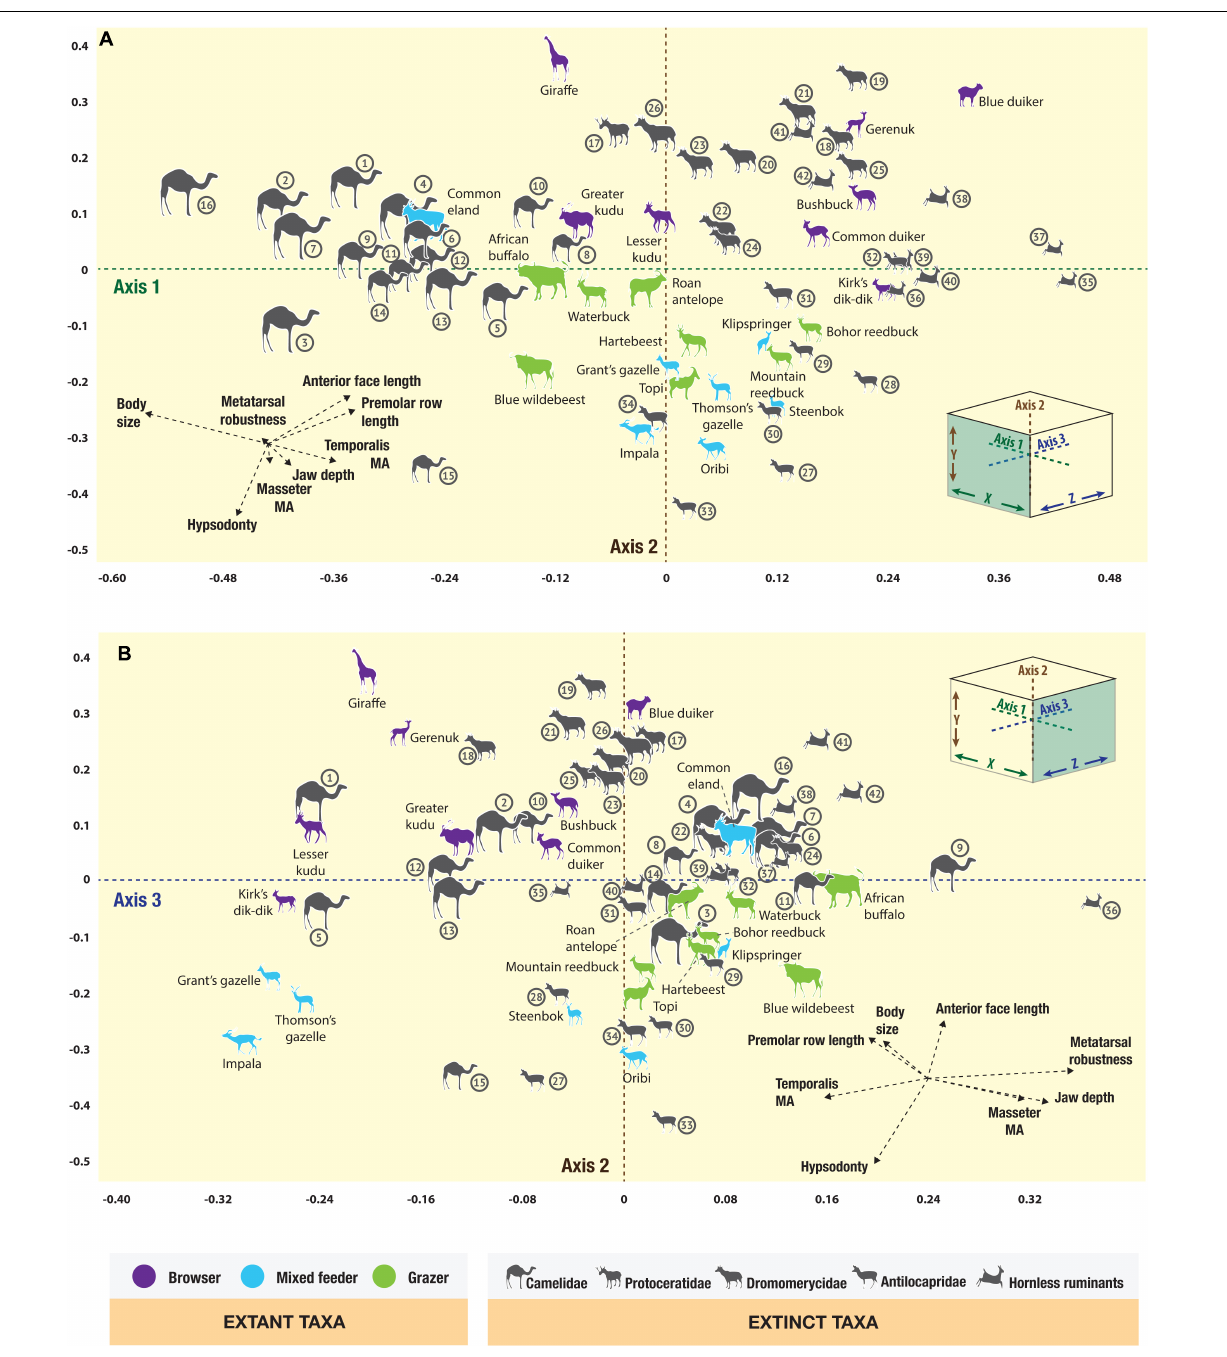
Frontiers in Earth Science |